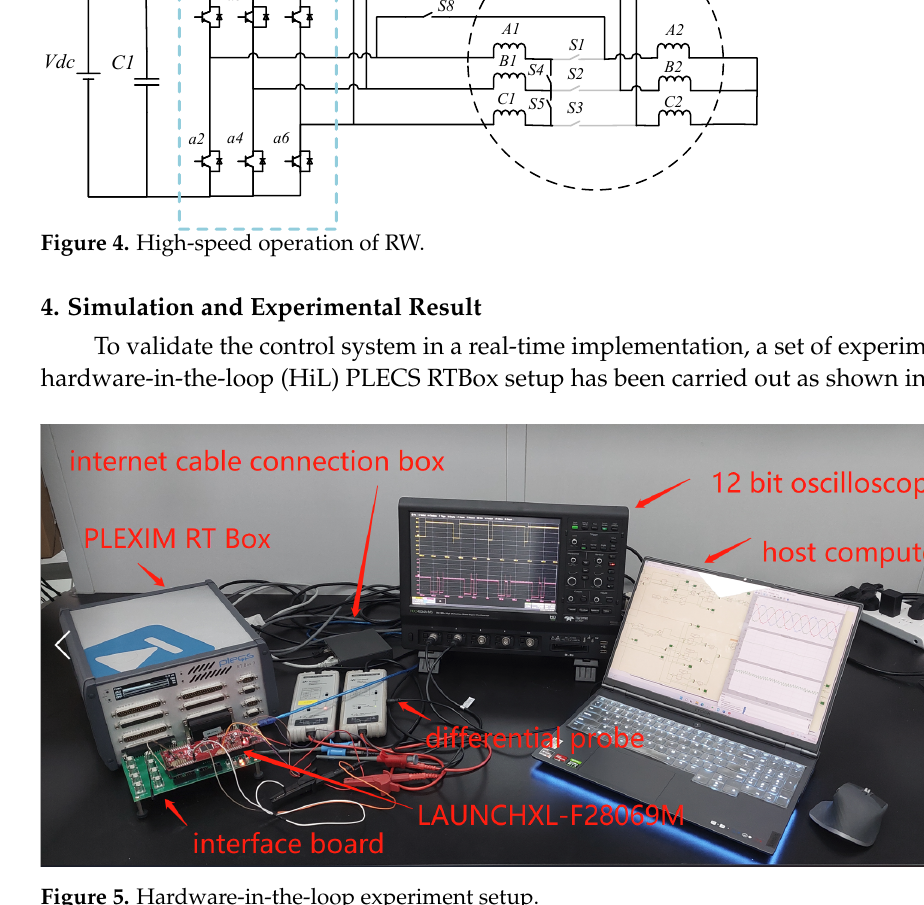
Figure 5. Hardware-in-the-loop experiment